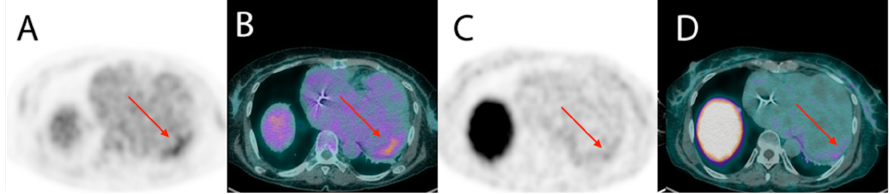
Figure 8. Increased cardiac volume in a patient with Chagasic cardiomyopathy. Mild increase in uptake of 18F-FDG ( A and B ) and of 68Ga-DOTATOC ( C and D ) in positron emission tomography (PET)-CT images was restricted to the basal anterolateral segment, indicating the presence of inflammation in this segment.